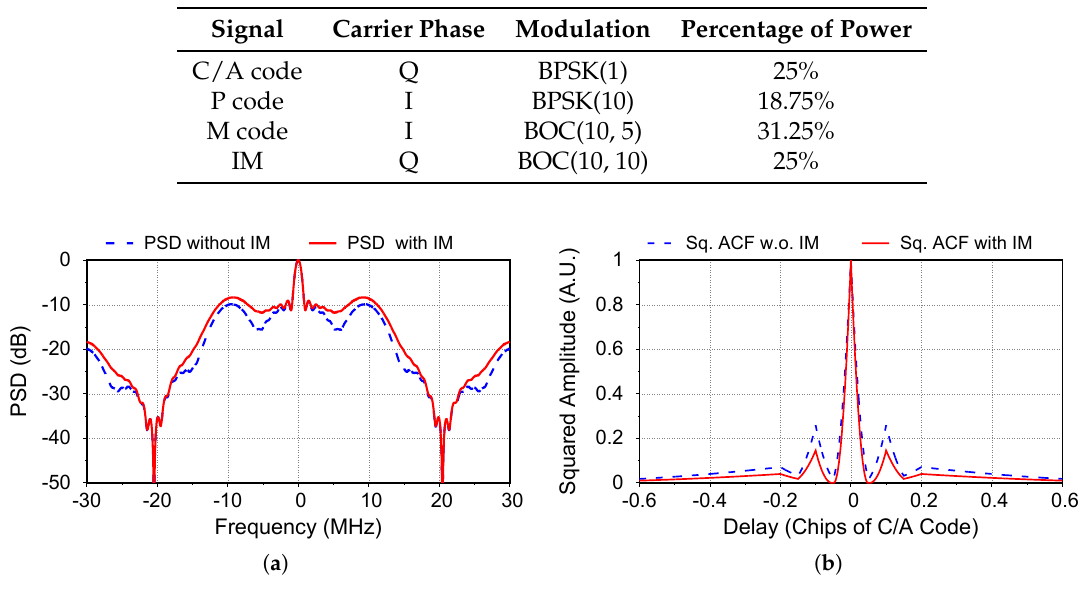
Figure 3. Power spectral density (PSDs) and Woodward Ambiguity Functions (WAFs) of GPS L1 composite signal by considering the IM component. ( a ) PSDs of the composite signal with and without considering the IM component; ( b ) Squared ACF of composite GPS L1 signal with and without considering the IM